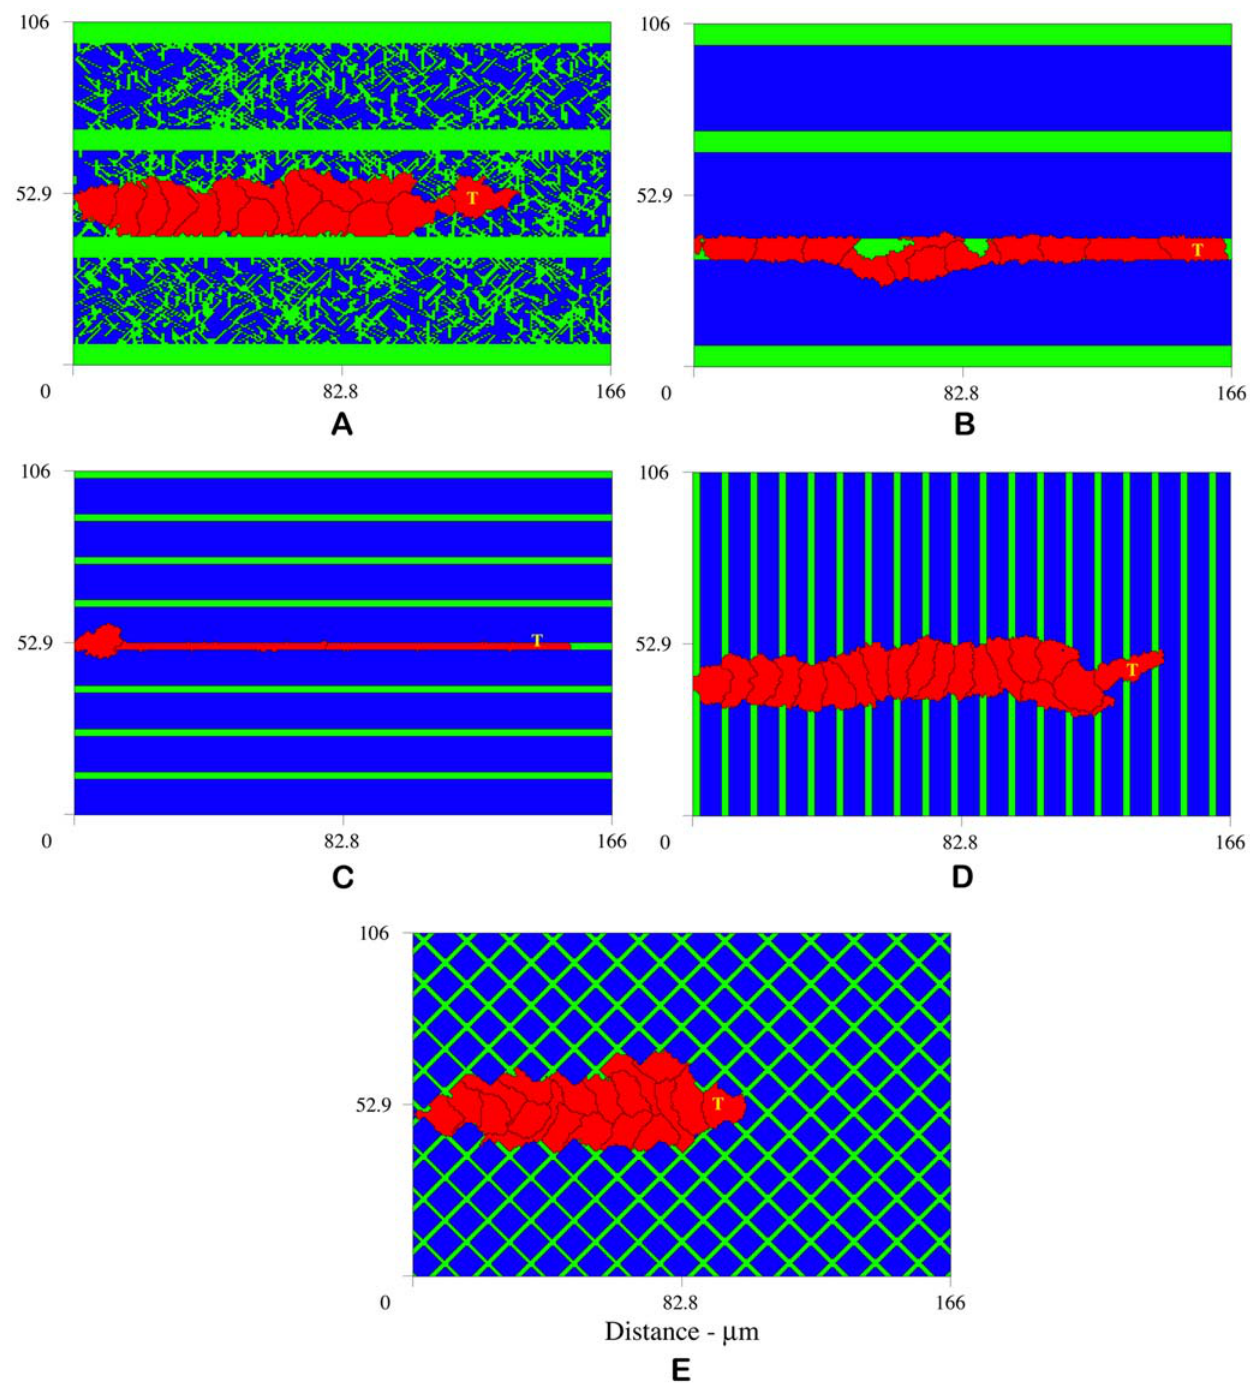
Figure 5. Sprouts developing on patterned matrices reveal a strong correspondence between fiber alignment and cell shape and orientation. Sprouts migrate toward higher concentrations of VEGF, however, cells elongate and are clearly oriented in the direction of the matrix cords. (A) Matrix of randomly distributed fibers augmented with horizontal cords 7.2 m m thick, (B) matrix cords 7.2 m m thick aligned horizontally, (C) horizontal cords 2.2 m m thick, (D) vertical cords 2.2 m m thick, and (E) crosshatched cords. Horizontal cords are aligned with to the VEGF gradient (0 u ); vertical cords are perpendicular to the gradient (90 u ); crosshatched cords form a 6 45 u angle with the VEGF gradient. These results demonstrate the important role of contact guidance and tissue structure in determining cell shape and orientation. Snapshots at 12.5